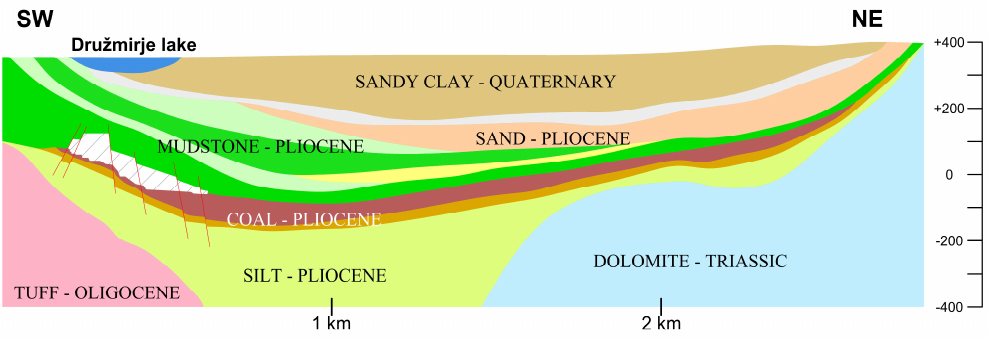
Figure 3. Schematic SW-NE trending geological cross section [4].